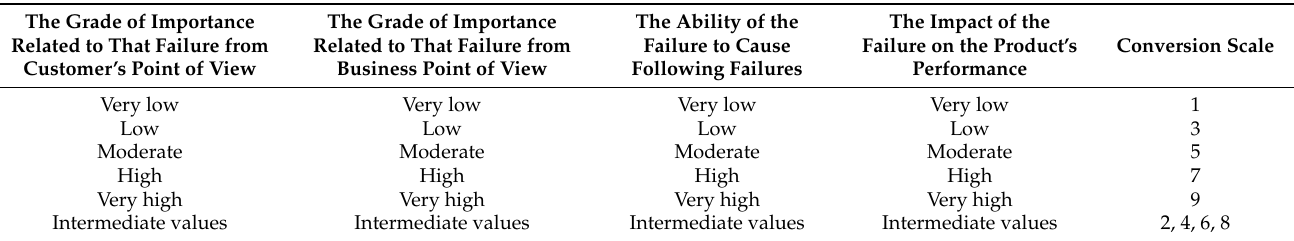
Table 3. Conversion scale of linguistic terms of qualitative criteria.